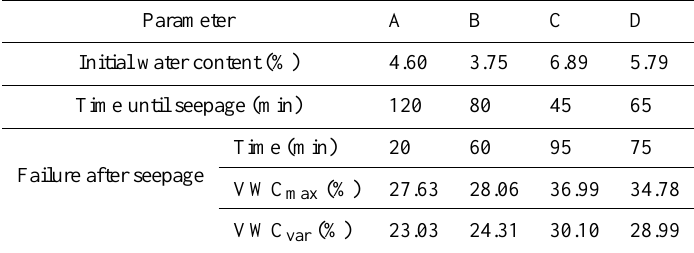
Table 5. Variation of volumetric water content in the model slope of 70 ◦ inclination. Parameter A B